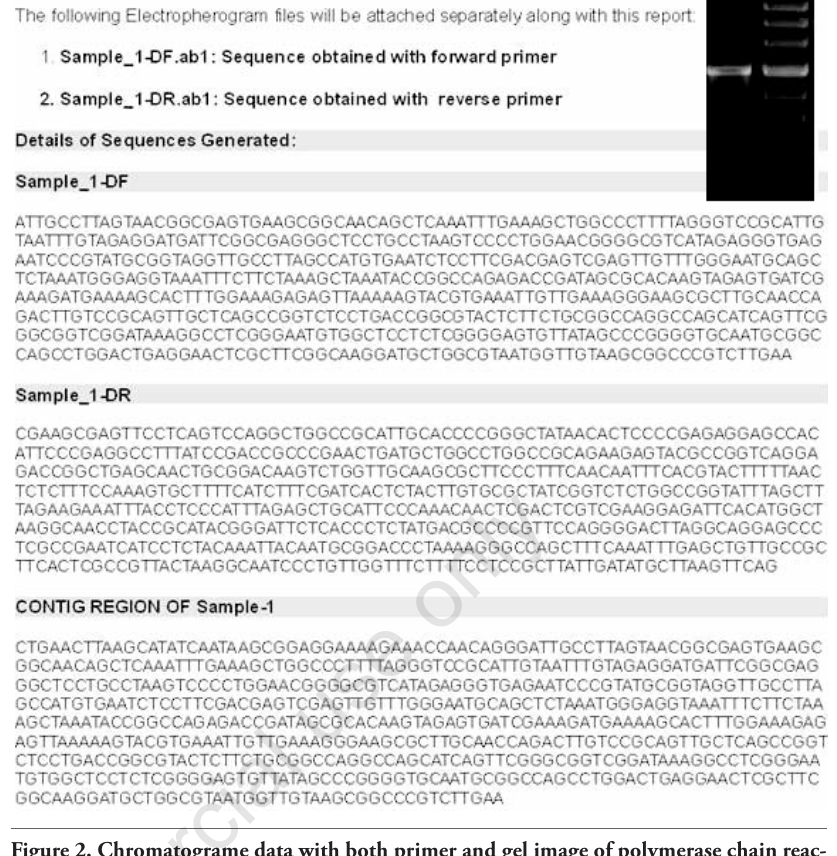
Figure 2. Chromatograme data with both primer and gel image of polymerase chain reac- tion